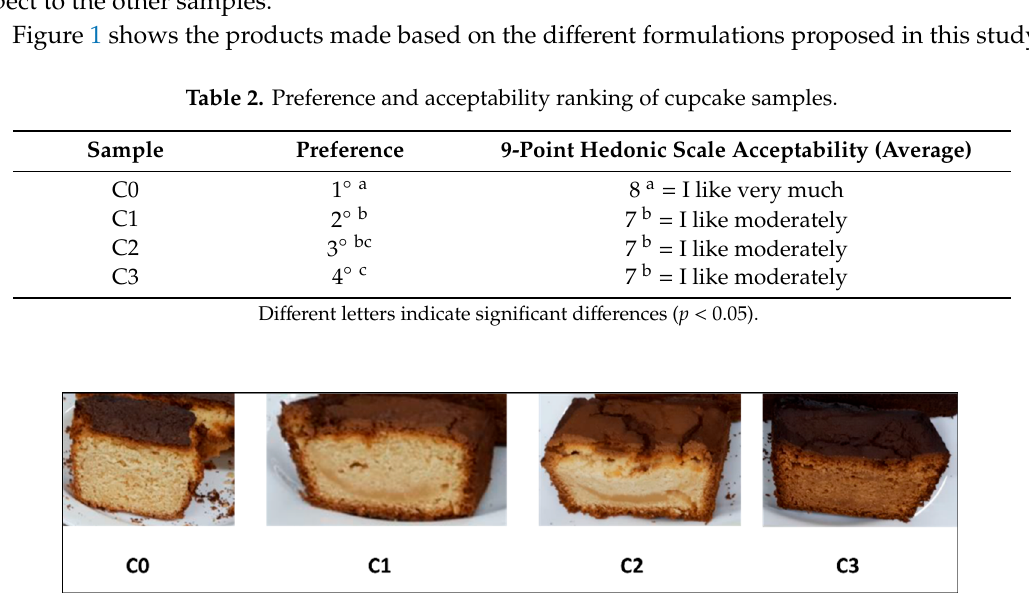
Figure 1. Photos of cupcake samples. Where di ff erent samples are C0 = based in Sugar; C1 = based in Stevia, Maltitol and Polydextrose; C2 = based in Sucralose, Maltitol and Polydextrose; C3 = based in Tagatose, Isomaltitol and Soluble Fiber.